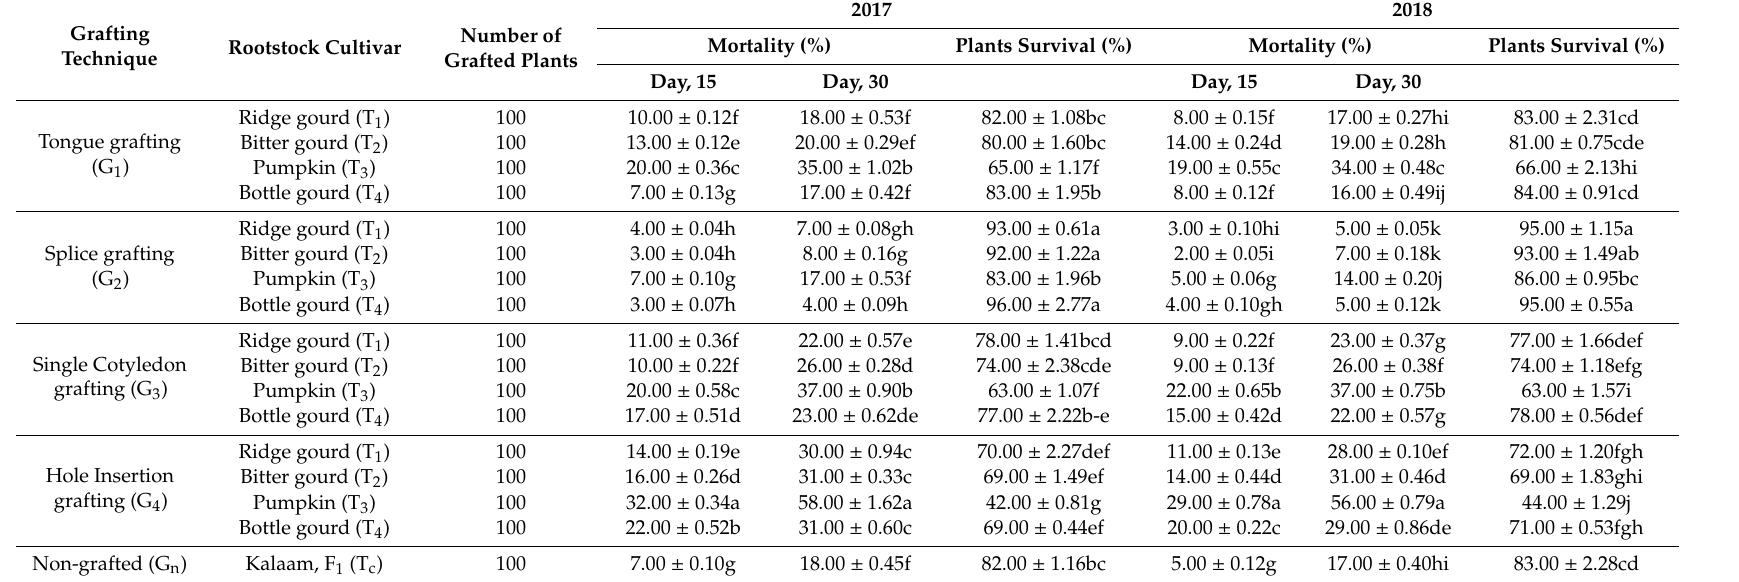
Table 2. E ff ect of grafting hybrid cucumber cv. Kalaam F 1 onto local rootstocks on plant survival